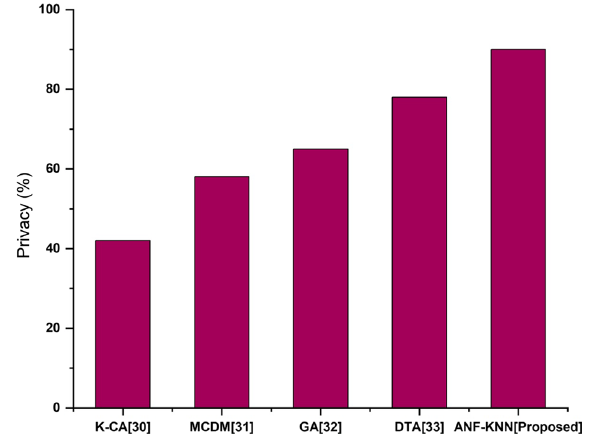
Fig. 10 Privacy comparison of existing and proposed